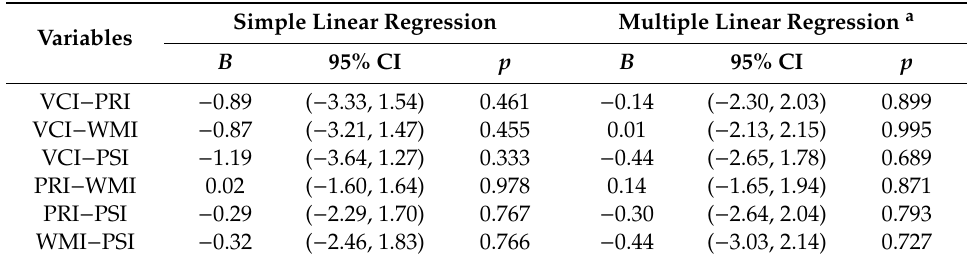
Table 7. The regression analysis between subtest-level discrepancy and duration of symptoms in the exotropia group.